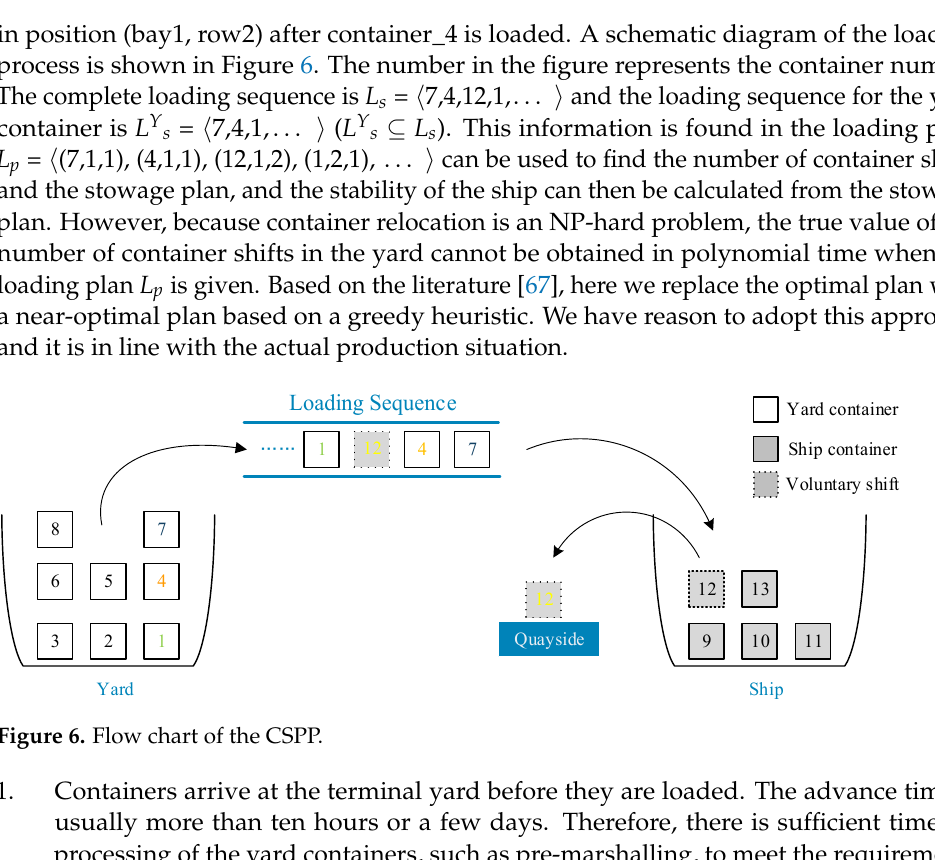
n ID B R Figure 5. Schematic diagram of chromosome coding. Figure 5 shows a legal chromosome code through which a complete loading plan can be obtained: L p =  (7,1,1), (4,1,1), (12,1,2), (1,2,1), …  . The first triplet (7,1,1) represents that container_7 was first loaded on the ship and its location on the ship was (bay1, row1), then container_4 was loaded onto the ship, and its position is (bay1, row1) as well. Con- tainer_12 is the “voluntary shift” container, i.e., the container on the ship. It needs to be temporarily moved to the side of the dock for container relocation at a future port, and then is loaded onto the ship according to the “new” loading sequence. Then, the container will be loaded in position (bay1, row2) after container_4 is loaded. A schematic diagram